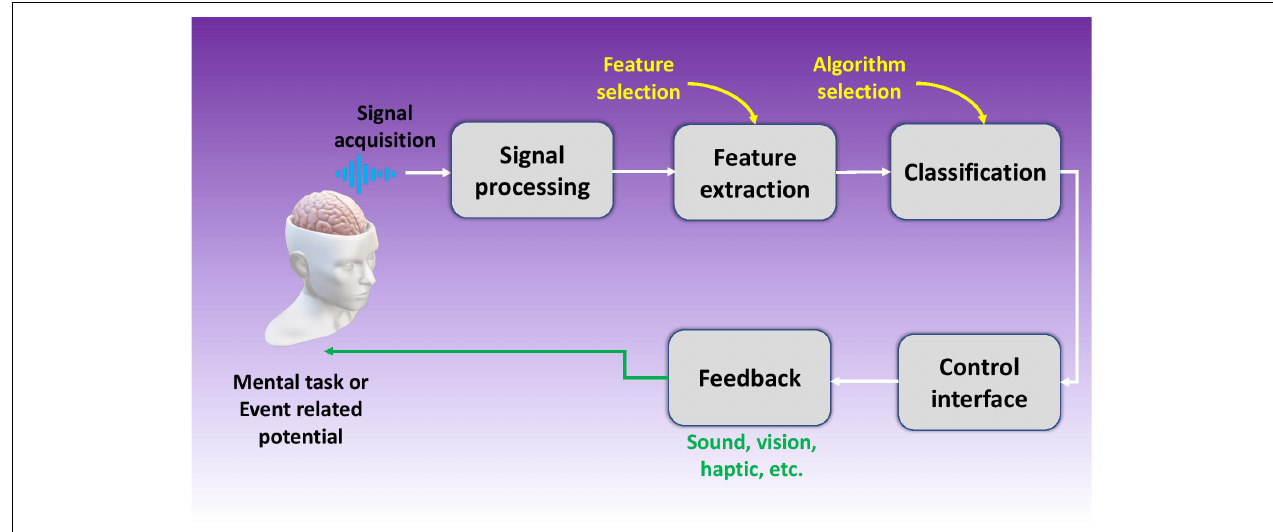
FIGURE 1 | Schematic illustration of a brain machine interface using five stages including signal acquisition, signal processing, feature extraction, data classification, and the control